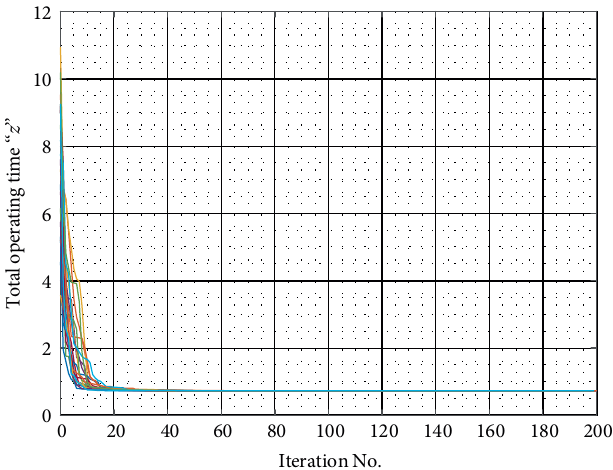
Figure 9: Convergence characteristics of JAYA for 20-time execution for Case 3 for the objective function mentioned in equation (49).